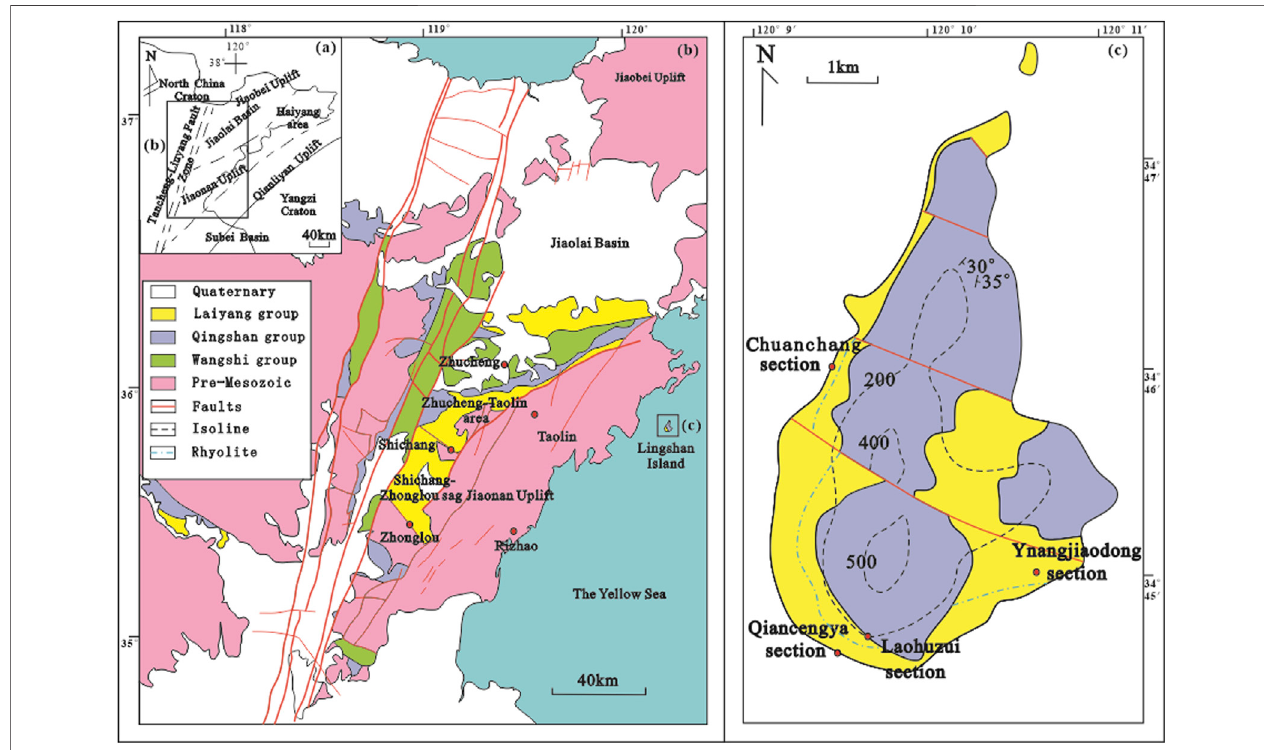
FIGURE1| Geotectonic location and geological schematic diagram ofLingshan Island. (A,B) Location and tectonic setting aroundLingshanIsland, modi fi ed after Shen et al. (2016) and Zhang et al. (2017). (C) The geological sketch map of Lingshan Island, modi fi ed after Luan et al. (2010).